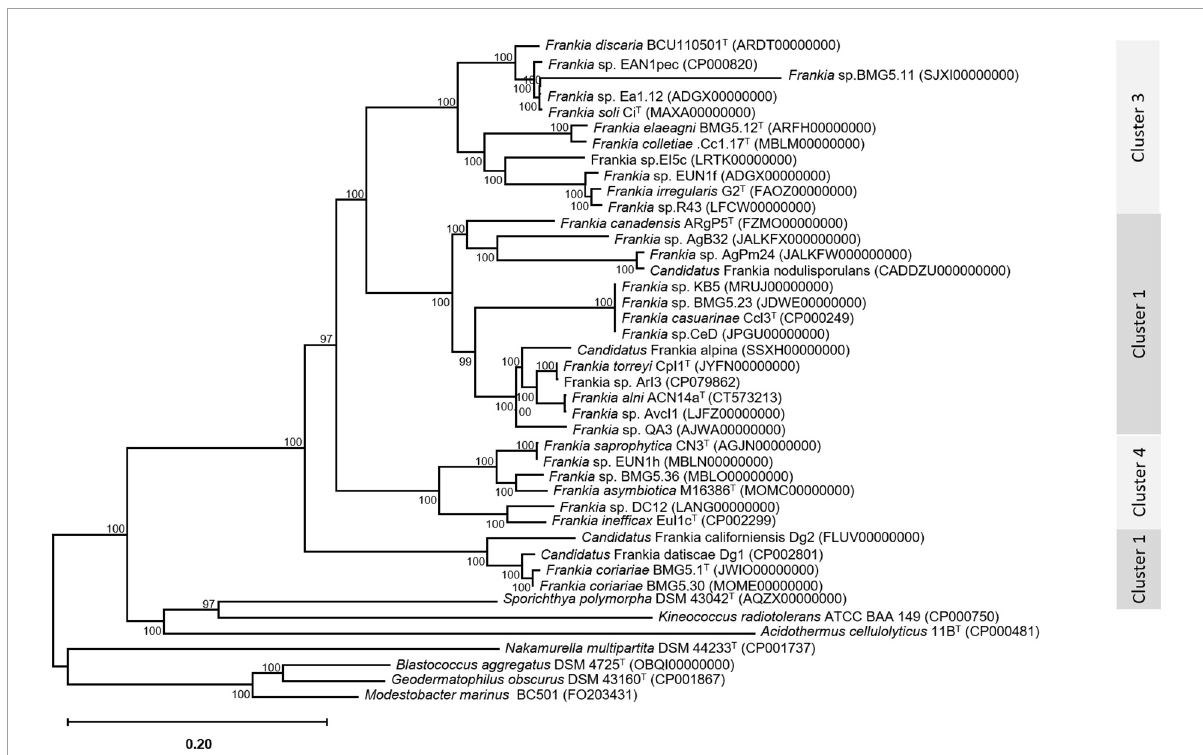
FIGURE2 A maximum-likelihood tree inferred by the module “CoreTree” of PGCGAP v1.0.21 (Liu et al., 2020) with the best-fit model JTT + F + R4 and based on the concatenation of single-copy conserved proteins. The midpoint-rooted phylogenetic tree of single-copy core